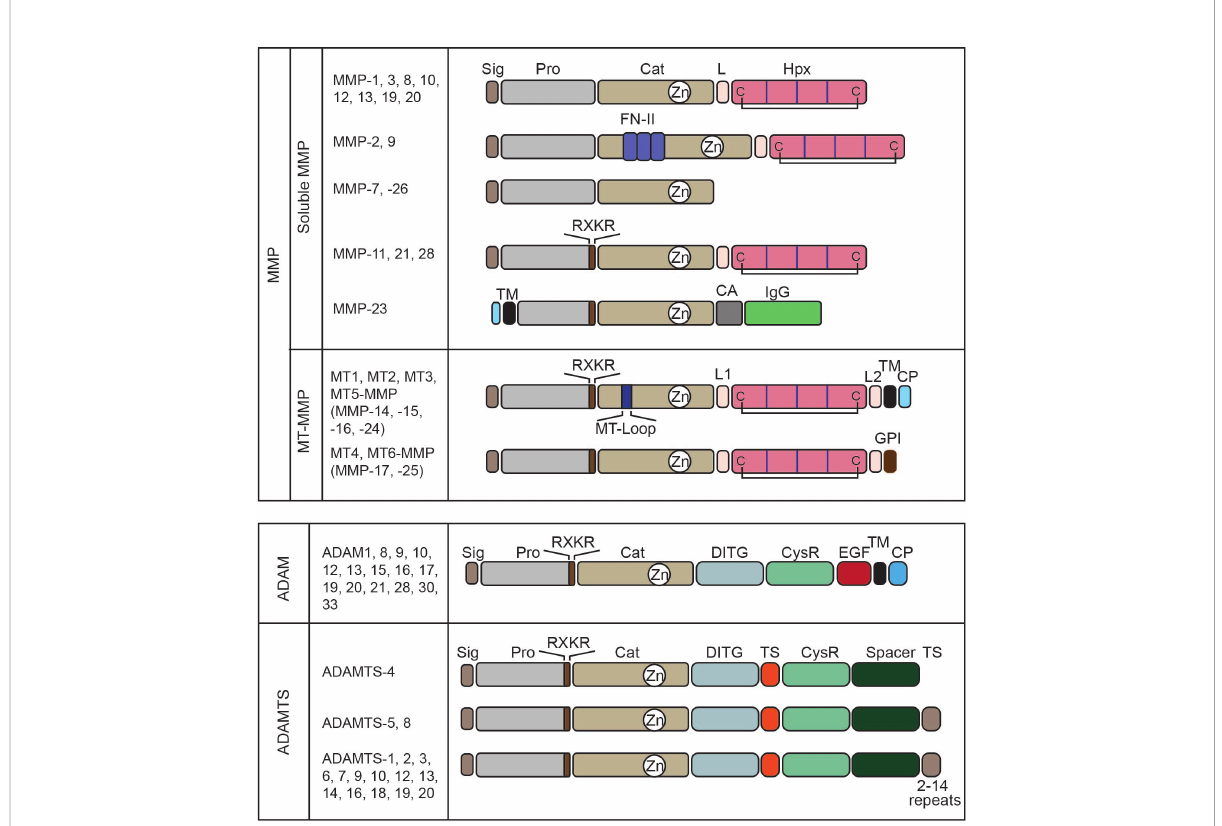
FIGURE 2 Domain structure of metalloproteinases. Matrix metalloproteinases (MMPs) can be divided into two major groups: soluble MMPs and membrane-type MMPs. According to their structures, they can be classi fi ed into six soluble MMPs and two subgroups in membrane-type MMPs. MMP-11, 21, 28, 23, and MT-MMPs have a basic motif of RXKR that is recognized and cleaved by proprotein convertases to activate the enzymes by removing their pro-domain. Sig, signal peptide; Pro, pro-domain; Cat, catalytic domain; L, linker or hinge region; Hpx, hemopexin domain; C, cysteine; FN-II, fi bronectin type-II repeats; TM, transmembrane domain; CA, cysteine array; IgG, IgG-like domain; L1, linker1 or hinge region; L2, linker 2 or stalk region; MT-Loop, eight amino acids insertion unique to TM-type MT-MMPs; and CP, cytoplasmic domain. ADAM enzymes have a conserved domain structure. DITG, a disintegrin-like domain; CysR, a cysteine-rich domain; EGF, an EGF-like domain. ADAMTS enzymes also have a conserved domain structure and differ in the number of thrombospondin motifs (TS) at their C-terminus. ADAMTS-4 is the smallest, without a C-terminal TS, and ADAMTS-5 and 8 have two. Other members have 2 – 14 repeats. Spacer, spacer domain. Both ADAM and ADAMTS enzymes have an RXKR motif at the C-terminus of their propeptide for activation by proprotein